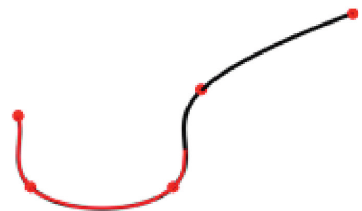
Figure 9: Best optimal curve achieved.